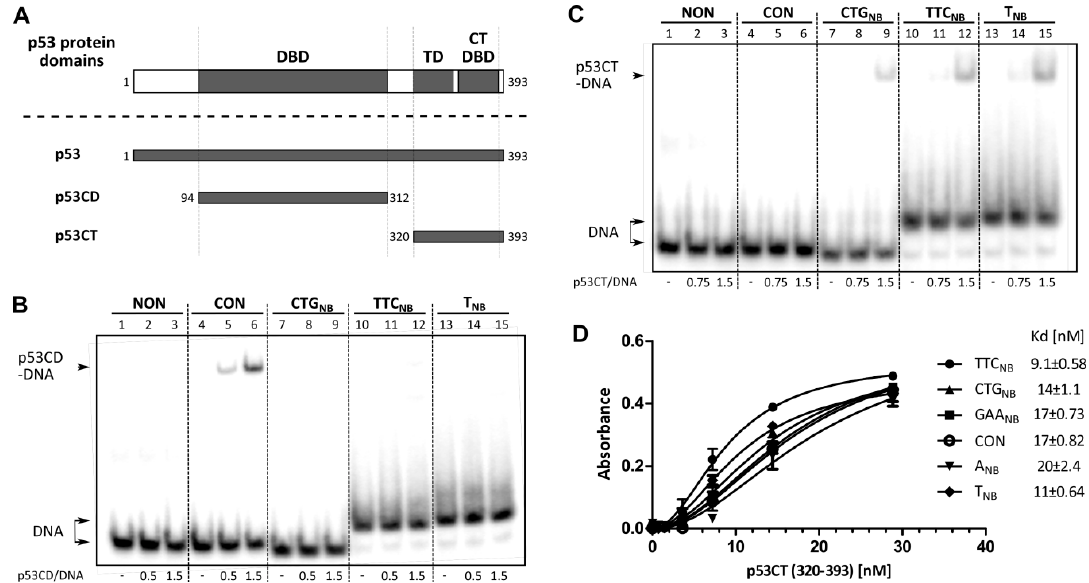
Figure 2 . Role of core and C-terminal DNA binding domains in p53 non-B DNA recognition. ( A ) Full- Figure 2. Role of core and C-terminal DNA binding domains in p53 non-B DNA